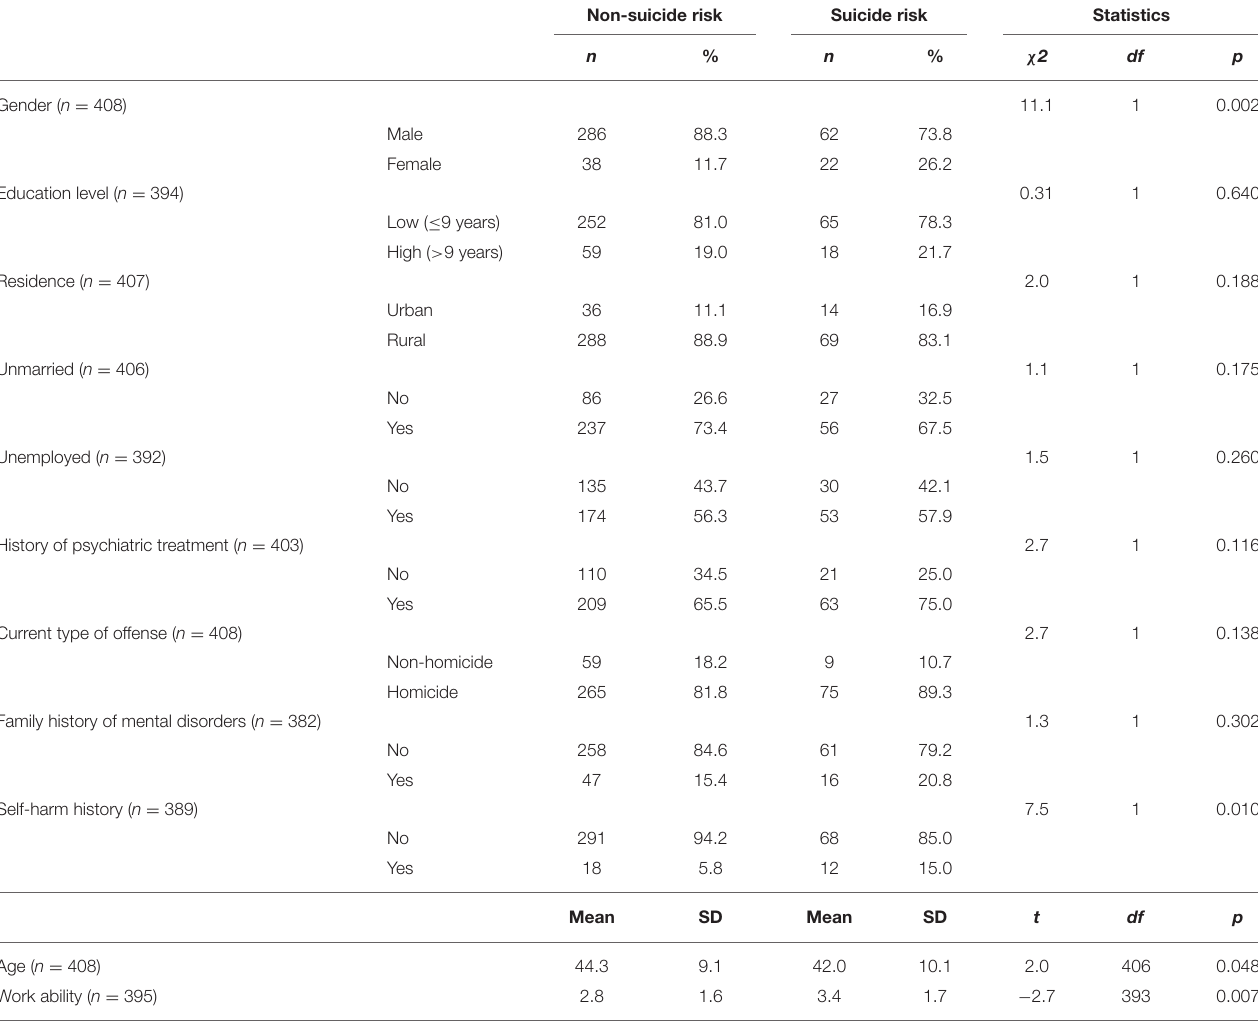
TABLE 1 | Socio-demographic and criminological characteristics of the sample.